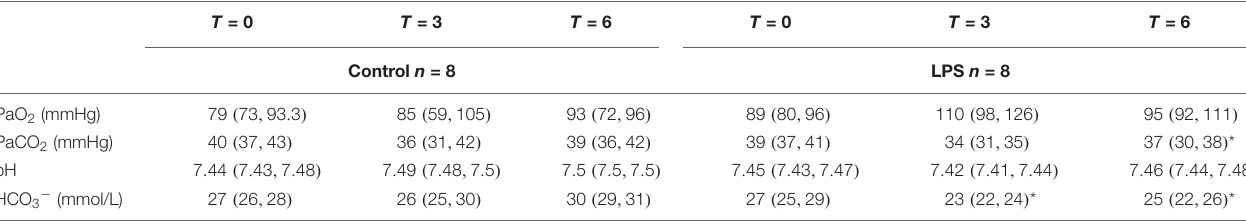
TABLE 1 | Arterial blood gases for each